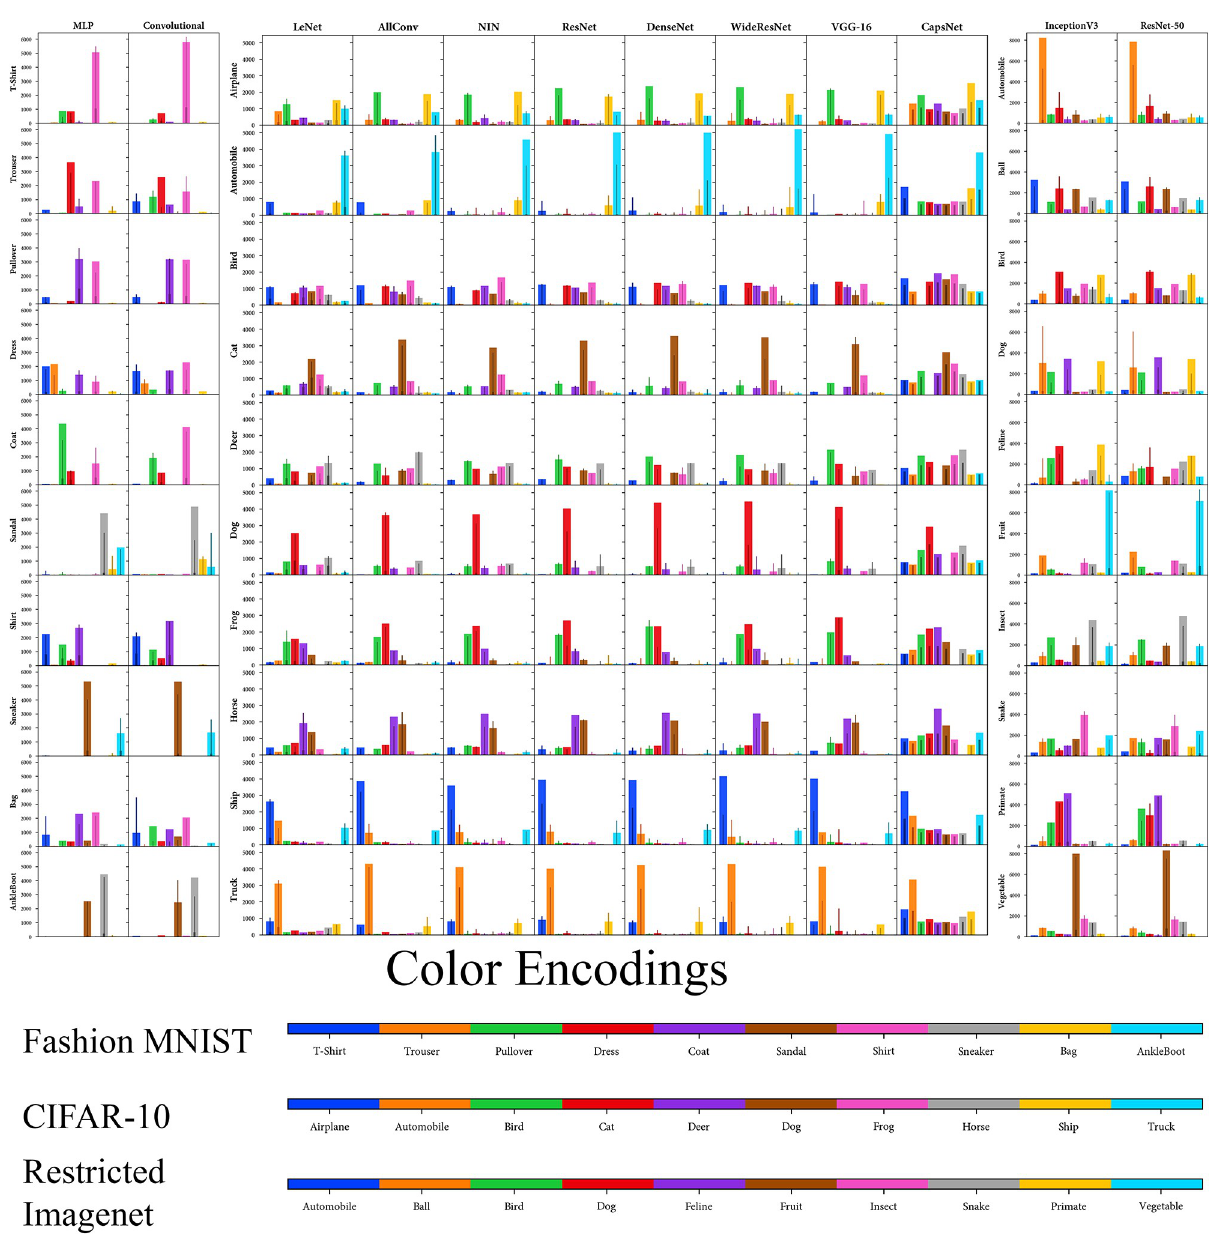
Fig 4. Histograms of soft-labels ( H 0 and H ) from which the AM is calculated. Each row shows the histograms of one classifier with one class excluded. Dark-shaded thinner and light-shaded broader bins are respectively the soft-labels from the ground-truth ( H 0 ) from the classifier trained on all classes and the soft-labels of the classifier trained on N − 1 classes ( H 0